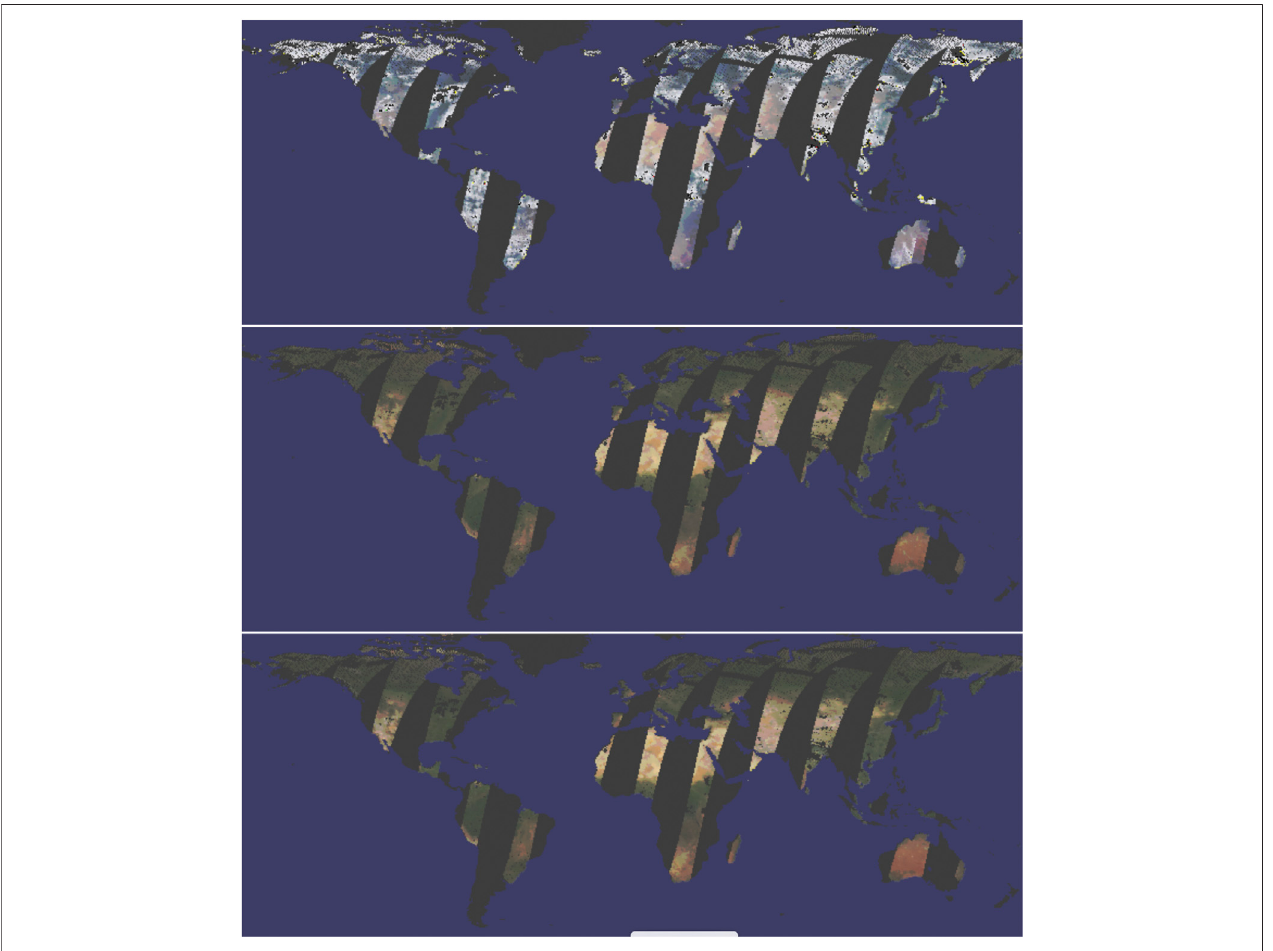
FIGURE 7 | Top: GOME-2 RGB image from August 2, 2018; Middle: Reconstructed surface RGB image from GOME-2; Bottom: Surface RGB from MODIS MCD43 averaged over GOME-2 pixels. Snow/ice covered pixels are not masked out. Orbital gaps as well as pixels with re fl ectances > 0.7 or not passing the reconstruction check are masked out. Ocean data are colored as blue and are not considered in this study.